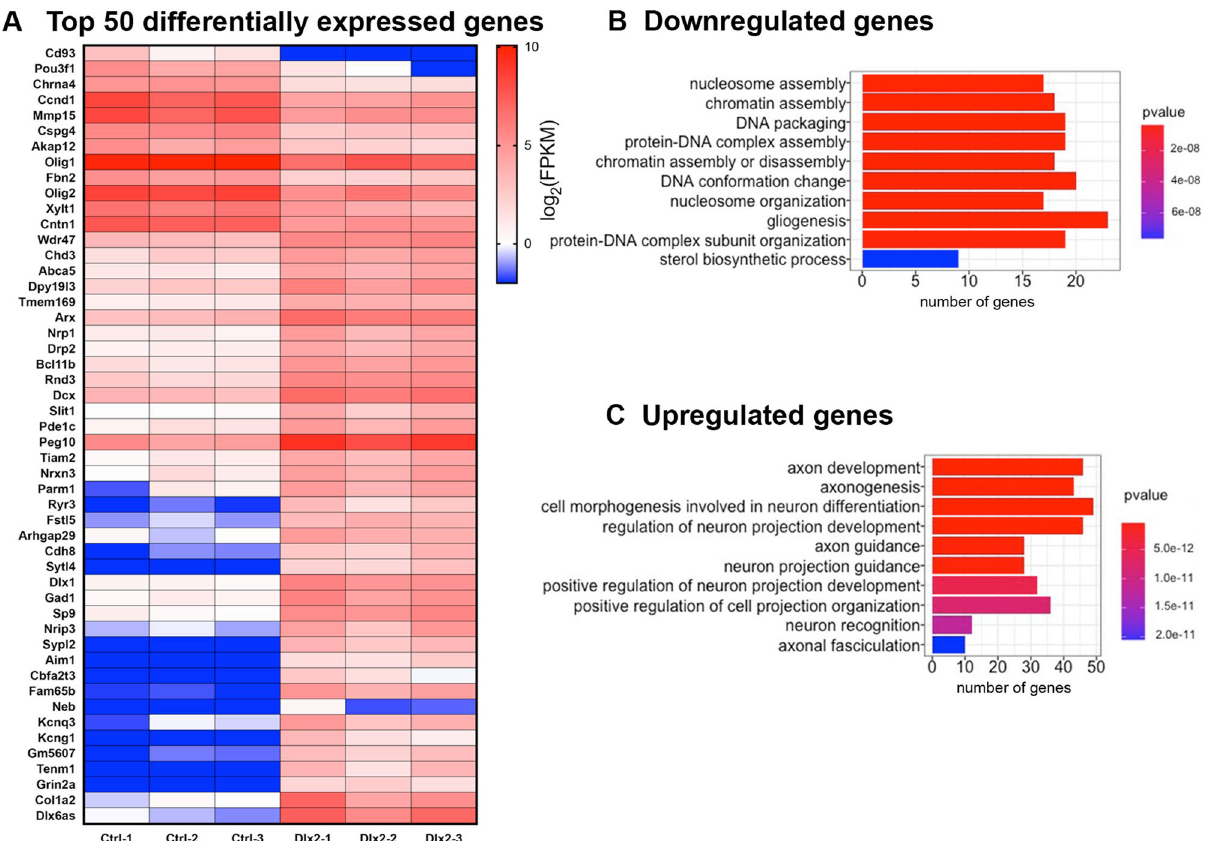
Figure 2. Dlx2 induces GABAergic neuronal genes in OPCs within 2 days. ( A) Heatmap of the 50 most significantly differentially expressed genes. Columns represent control-transfected biological replicates (Ctrl- 1, Ctrl-2, Ctrl-3) and Dlx2-transfected biological replicates (Dlx2-1, Dlx2-2, Dlx2-3). Color scale depicts log 2 (FPKM) values. ( B,C ) The top 10 most significant gene ontology (GO) terms enriched for significantly upregulated ( B ) or significantly downregulated ( C ) genes, graphed in order of significance. Horizontal-axes represent the number of genes matched to each GO term. Legends show the color scale for the p ing vesicular glutamate transporter VGLUT1 35 or Tbr1 (T-box brain protein 1) encoding a transcription factor expressed in pyramidal neurons in the deep neocortical layers (Fig. 3A) 36 . These findings indicate that transient episomal Dlx2 misexpression in OPCs was sufficient to selectively upregulate inhibitory neuron transcription factor expression and initiate the program of differentiation towards GABAergic inhibitory neurons in 2 days. Changes in chromatin modifiers during fate switch into GABAergic neurons. To predict potential changes to the chromatin architecture during the early phase of neuronal reprogramming of OPCs, we next examined the RNA-seq dataset at 2 dpt to see whether Dlx2 overexpression altered the levels of transcripts encoding chromatin modifying factors. Among histone deacetylases (HDACs), there was a 3.7-fold upregulation of Hdac11 (Supple- mental Fig. 3B), which encodes a class IV histone deacetylase and is implicated in spinal motor neuron survival by interacting with the mRNA splicing machinery 37 . Notably, there was no statistically significant change in Ezh2, which encodes the catalytic subunit of the polycomb repressive complex 2 (PRC2) responsible for depositing the repressive trimethylation mark on histone 3 lysine 27 (H3K27) at many inhibitory neuron genes in OPCs 15,38,39 . Nor was there any change in expression of Kdm6b, which encodes H3K27 demethylase. Among other histone posttranslational modifiers, Kdm3a and 7a were significantly upregulated. Kdm3a demethylates mono- and di- methyl H3K9. It interacts with Neurogenin-2 and increases chromatin accessibility for NeuroD1 and Tubb2b during neuronal differentiation 40 . Kdm7a, which demethylates di-methyl H3K27 and H3K9, promotes neural differentiation by increasing FGF4 expression 41 . Interestingly, among the transcripts encoding ATP-dependent chromatin remodeling enzymes, chromodomain helicase DNA binding protein 3 (Chd3), implicated in cortical layer specification 42 , was significantly upregulated. DNA methylation also regulates chromatin structure and gene transcription through the deposition of methyl groups at CpG islands. Dnmt1, which encodes maintenance DNA methyltransferase essential for correct alternative splicing during OL differentiation 43 , was significantly downregulated in Dlx2-transfected OPCs (Supplemental Fig. 3C). By contrast, the level of Dnmt3a encoding de novo DNA methyltransferase was not changed in Dlx2-transfected OPCs. These changes triggered by Dlx2 overexpression could have caused nucleosome repositioning and facilitated activation or derepression of critical genes during differentiation of OPCs into GABAergic neurons.